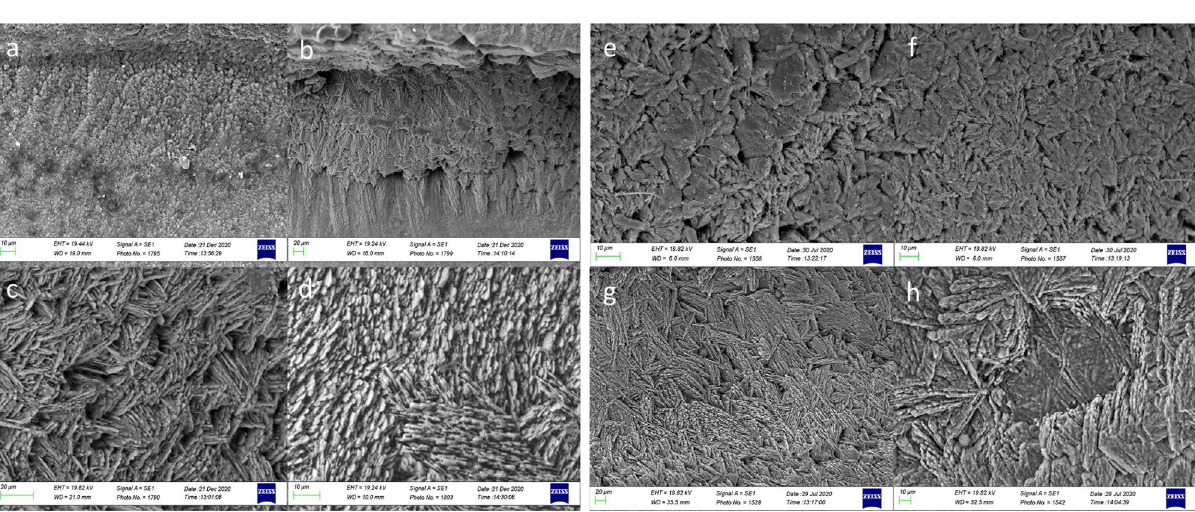
Figure 5. SEM images of the crystalline structure of P. bogaraveo , juveniles ( a , b ) and adults ( c , d ), and P. erythrinus , juveniles ( e , f ) and adults ( g , h )